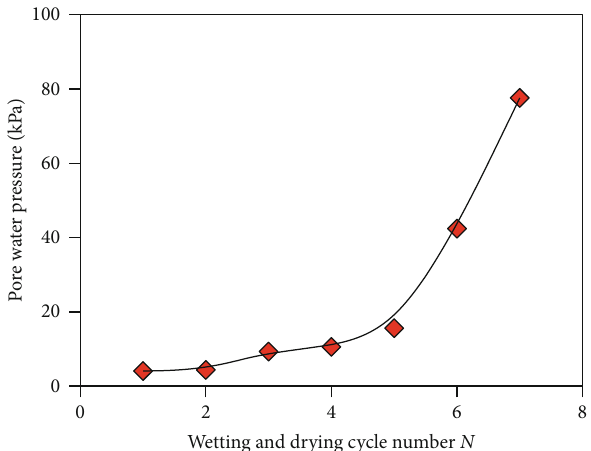
Figure 6: E ff ect of wetting-drying cycle number on the pore water